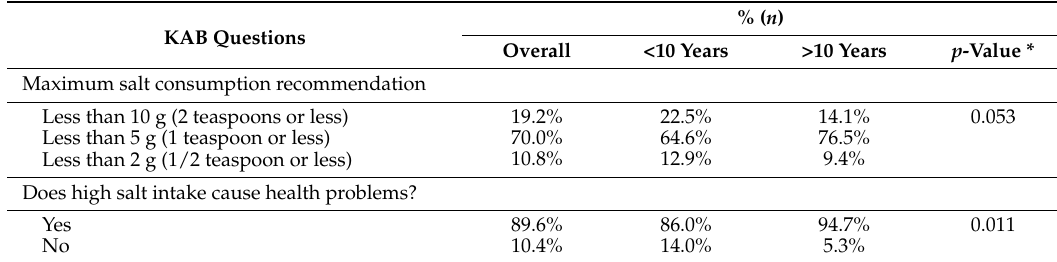
Table 3. Knowledge, attitudes and behaviours by level of education ( N =